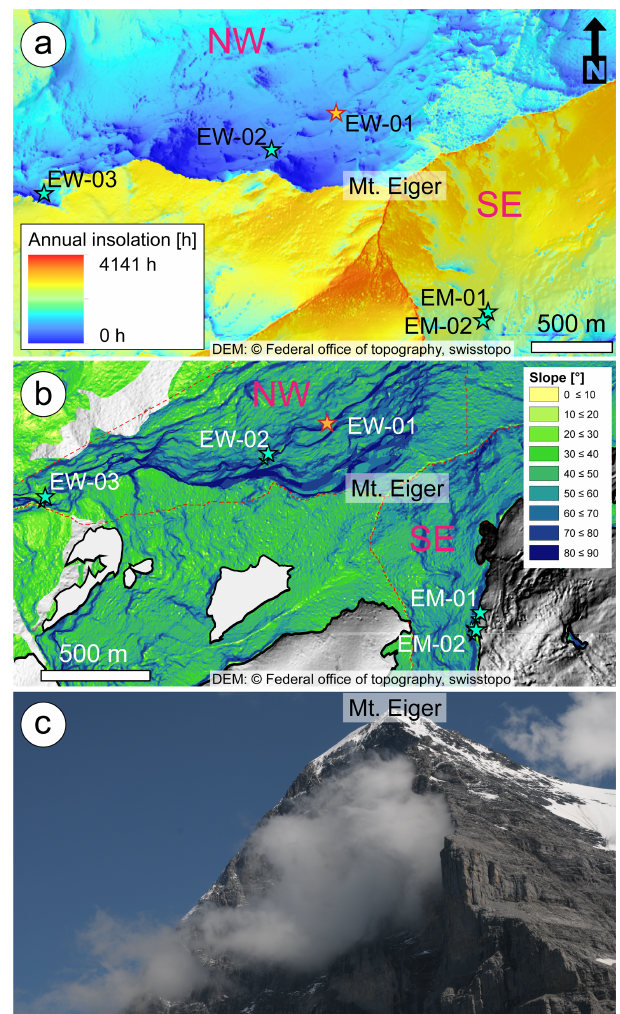
Figure 2. Differences in local temperature conditions between the NW and the SE face. (a) Potential annual solar insolation in hours over a year (2015), calculated using the hemispherical view- shed algorithm included in ESRIs ArcGIS ™ (Fu and Rich, 2002). (b) Slope angle map calculated from a high-resolution digital el- evation model (Swiss Alti3D 2m, 2015; provided by the Federal Office of Topography, swisstopo) for the northwest and southeast of the Eiger. (c) Field photograph of the NW wall, taken in the sum- mer of 2017, with local clouds illustrating the potential difference in microclimatic